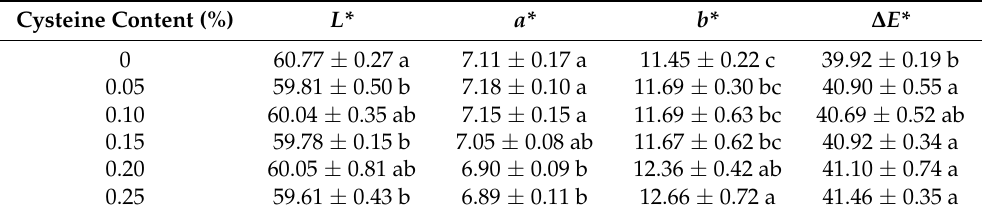
Table 1. Effects of cysteine content on the color of the